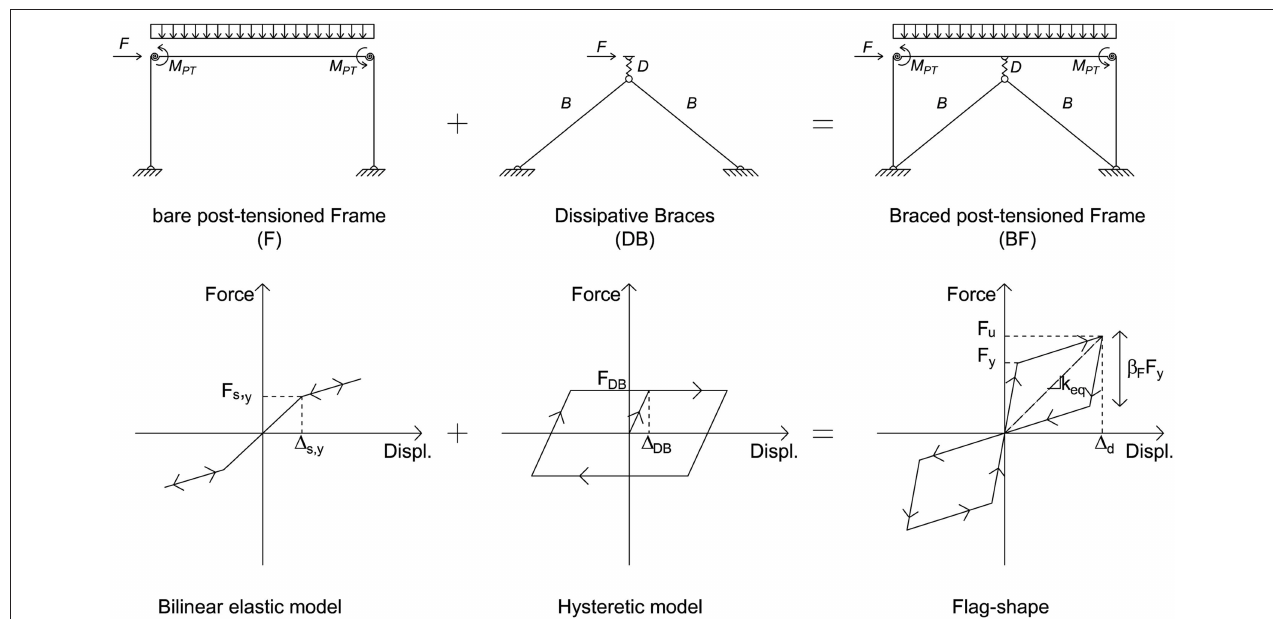
FIGURE 1 | Fundamentals of post-tensioned frame structure with dissipative bracing